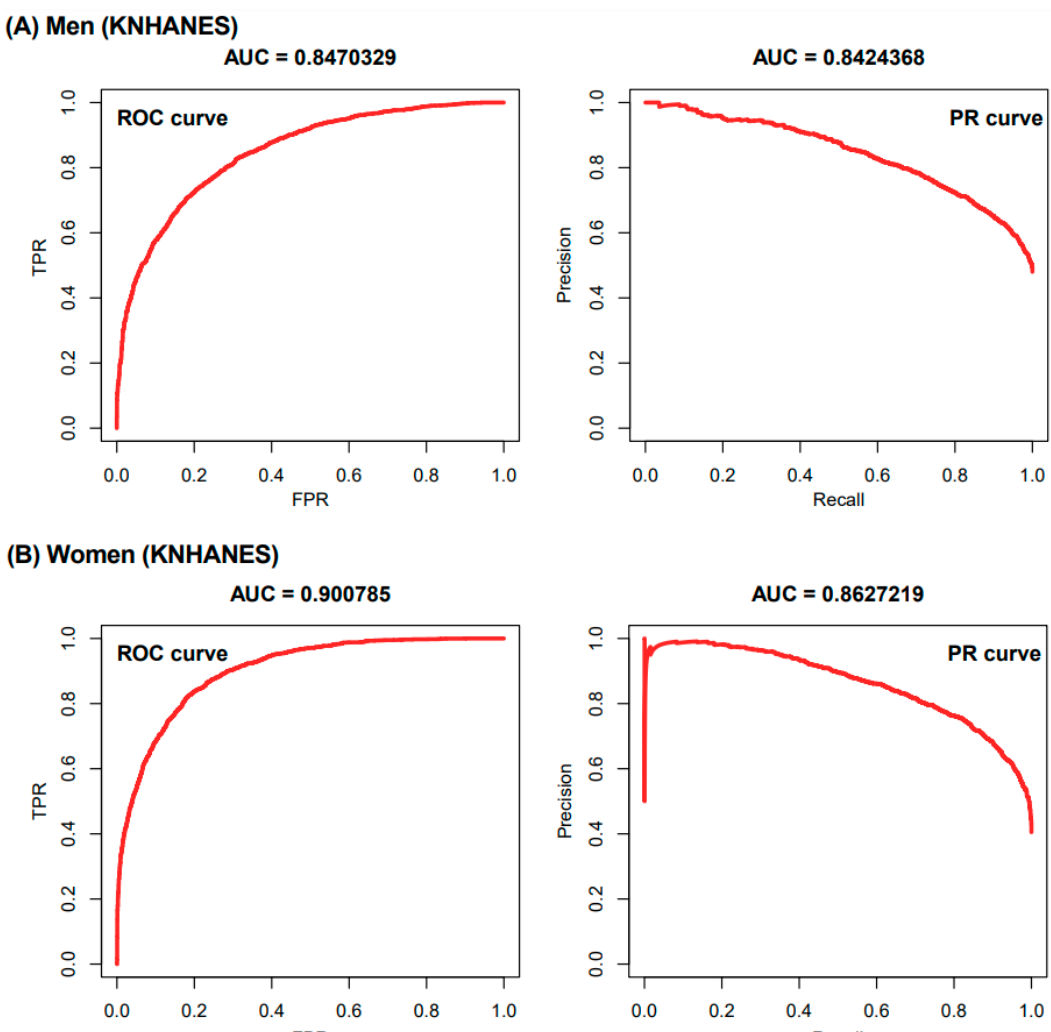
Figure 1. Receiver-operating characteristic curves for the sex-specific hypertension prediction model using KNHANES dataset from 2016 to 2018. ( A ) Men (AUC = 0.847) ( B ) Women (AUC = 0.901). Abbreviations: KNHANES, Korea National Health and Nutrition Examination Survey; ROC, receiver-operating characteristic; PR, precision-recall; AUC, area under the curve; TPR, true positive rate; FPR, false-positive rate.